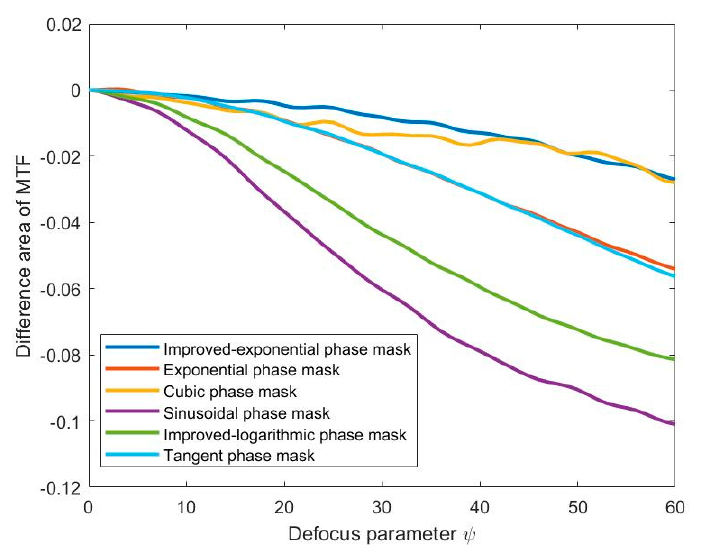
Figure 6. Difference area of MTF under different defocus parameters of improved exponential, exponential, cubic, sinusoidal, improved logarithmic, and tangent phase mask.